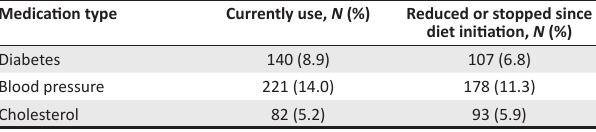
Note : Statistical results determined by chi-squared tests. TABLE 7: Medication use.